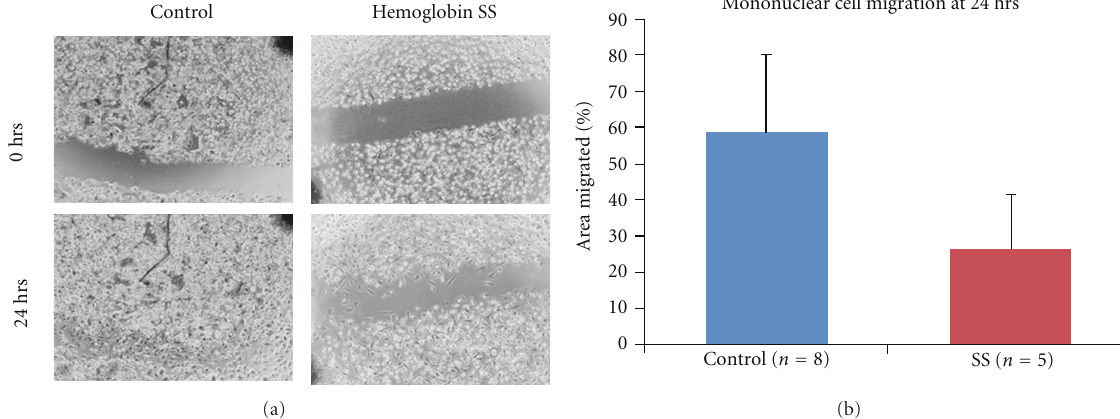
Figure 2: Mononuclear cell migration. Migration across a wound over 24 hours was significantly less in children with Hemoglobin SS than Controls. (a) shows a representative pair of Control and Hemoglobin SS wound migration assays. The freshly made wound was photographed at 0 (zero) hours, and the area migrated is measured after 24 hours. (b) shows the cumulative data for 8 Control and 5 Hemoglobin SS samples. The mean area migrated was less in children with Hemoglobin SS (28% versus 59% of the original wound area, P < 0 . 01).